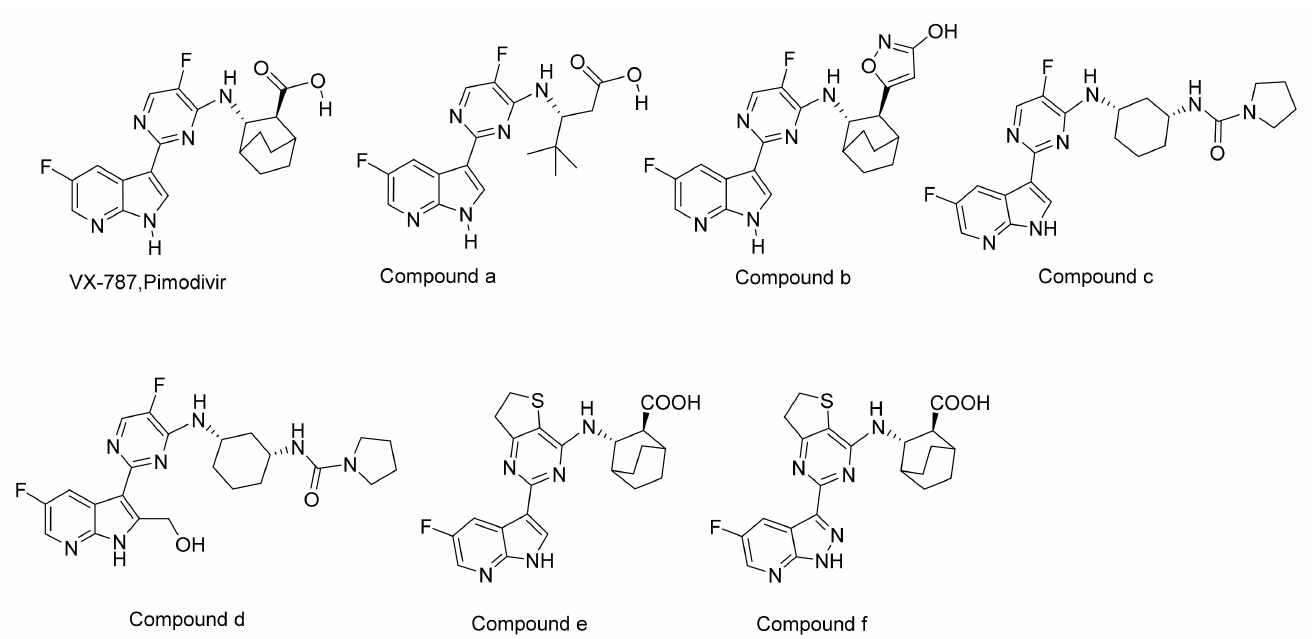
Figure 1. The structure of pimodivir and its derivatives.